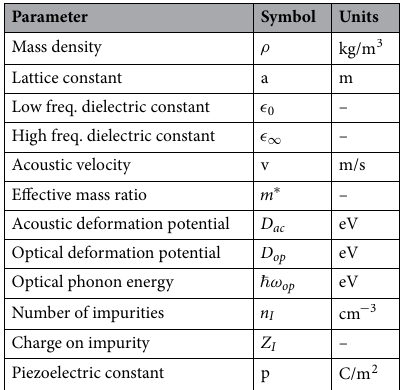
Table 1. Symbols and units for the scattering parameters required in various scattering